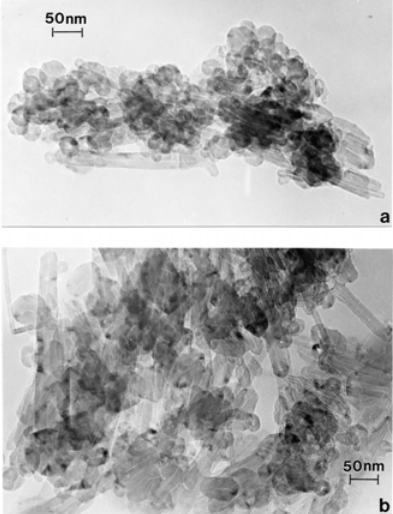
Figure 12: Propane flame-derived MWCNT aggregates collected by thermal precipitation and observed in the TEM. (a) Predominantly multiconcentric fullerene nano- PM. (b) Mixture of MWCNTs and multiconcentric, faceted fullerenic polyhedra. (From Murr, et al.